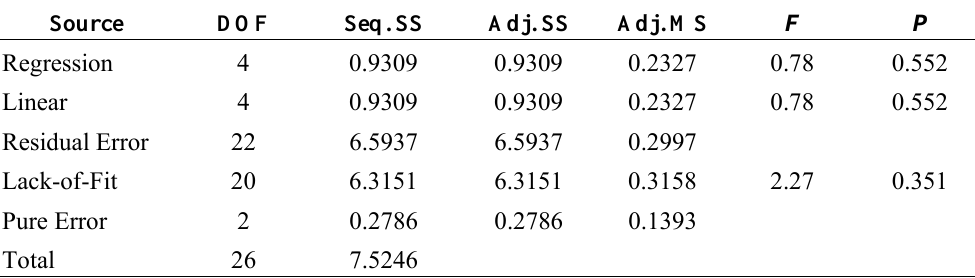
Table 4. Analysis of variance for first-order equation.